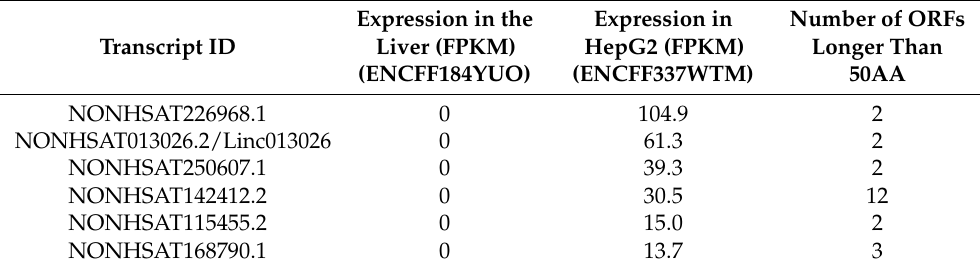
Figure 1. Identification of hepatocellular carcinoma-specific lncRNAs. ( A ) RNA-sequencing (RNA-seq) data from normal liver (ENCFF184YUO) and from the HCC cell line HepG2 (ENCFF337WTM) were aligned to the human reference genome (GRCh38) using Bowtie2. The gene expression values (Fragments per Kilobase Million (FPKM)) were calculated by Cuffnorm using the human NONCODE v5.0 transcript reference. A total of 906 long intergenic noncoding RNAs (lincRNAs) that were expressed in HepG2 cells but not in the normal liver were selected. Among these 906 lincRNAs twelve lincRNAs were expressed exclusively in HepG2 cells but not in the liver and other organs/tissues. ( B , C ) Abnormal chromatin structure induced expression of HCC-specific lincRNAs: Total RNA-seq from liver (ENCFF184YUO) and HepG2 cells (GSE115139), DNase-sequencing (DNase-seq) from normal liver (ENCFF851CVH) and HepG2 (ENCFF474LSZ) and candidate cis-Regulatory Elements (cCREs) generated by ENCODE consortium (ENCODE cCREs, blue mark) and cap analysis of gene expression (CAGE) data in HepG2 cells (ENCFF177HHM) were aligned to the human reference genome (GRCh38). SeqMonk was used to quantitate and visualize the data. Peaks in the wiggle plot represent the normalized RNA-seq, DNase-seq and CAGE read coverage on HCC-specific lincRNAs. E: exon; blue arrow: Open chromatin region at the putative promoter; black arrow: transcription start site (TSS) detected by CAGE. Table 1. List of six HCC-specific lincRNAs that contain at least one ORF longer than